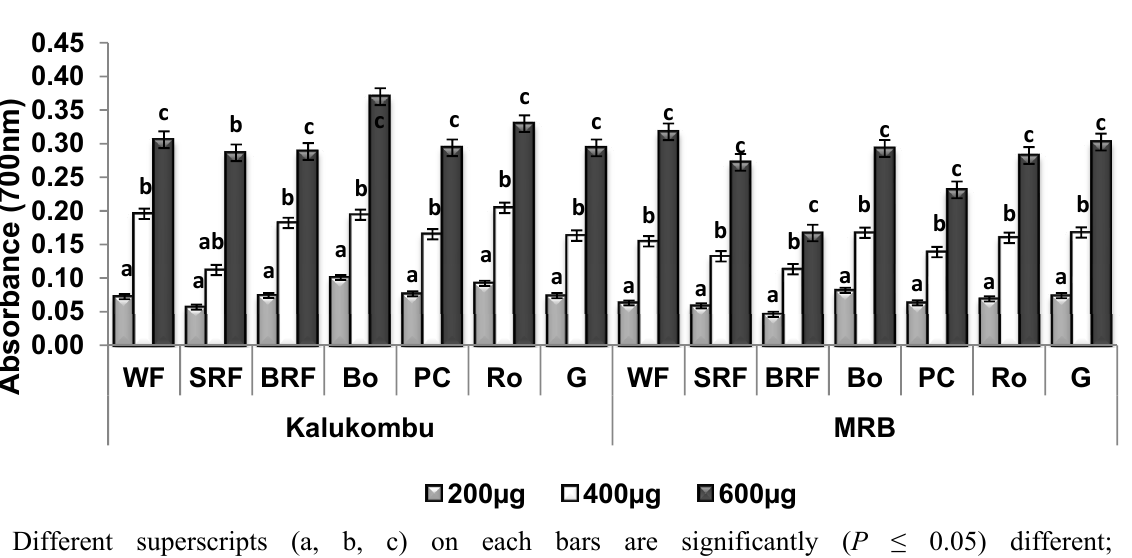
Figure 2. Effect of processing on the reducing power of pearl millet extracts at various